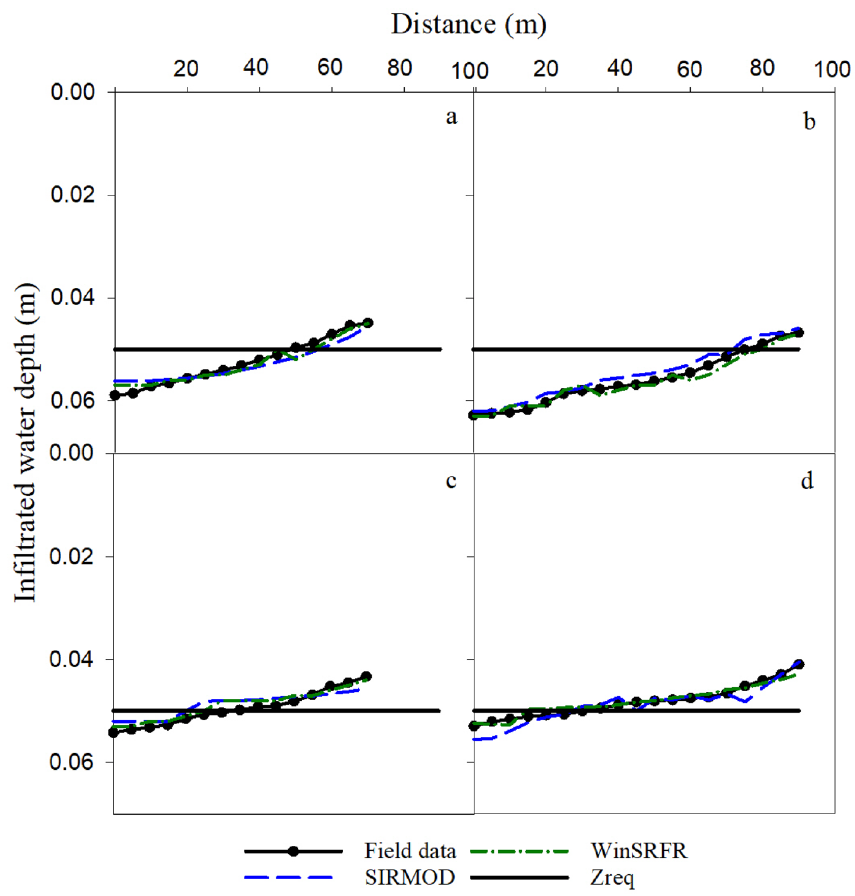
Figure 7. Comparison of the measured and simulated infiltrated depth under continuous irrigation ( a . Q 1 L 1 , b . Q 1 L 2 c . Q 2 L 1 and d . Q 2 L 2